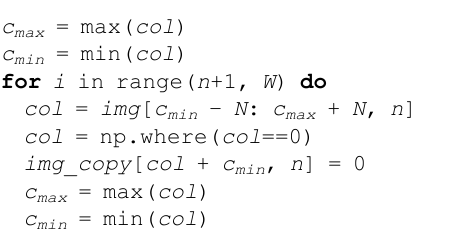
Fig 5. ECG pixel tracking algorithm. (a) Signal image with noise and artifacts; (b) ECG pixel tracking algorithm with N = 6; (c) Image of signal without noise and artifacts.